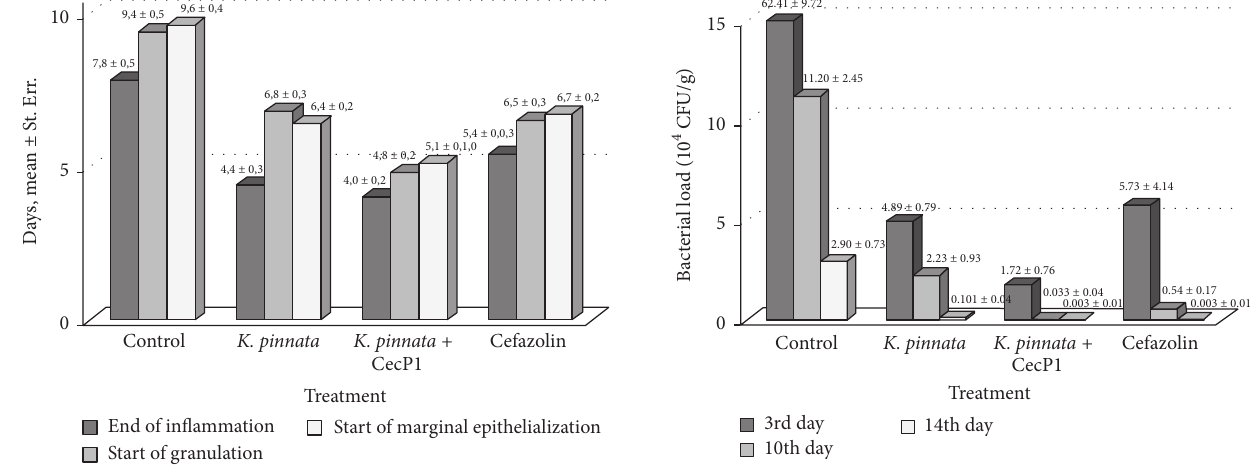
Figure 6: Testing healing of the wounds infected with combination of S. aureus and P. aeruginosa. Timing of wound recovery phases after beginning of curing (M ± Std . Err . ) is shown.